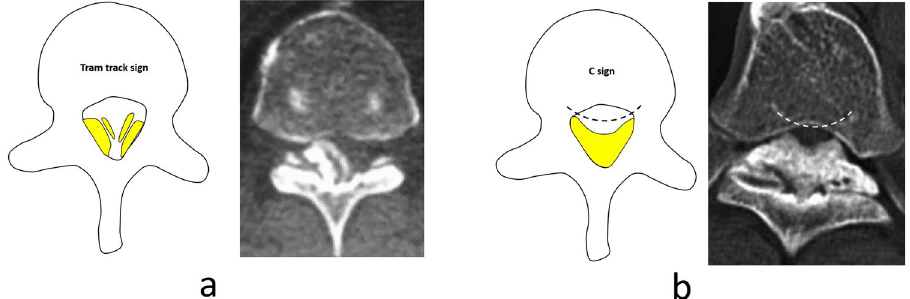
Figure 3. ( a ) Schematic diagram (left) and CT transverse scan (right) of the tram track sign; ( b ) Schematic diagram (left) and CT transverse scan (right) of the C-sign.